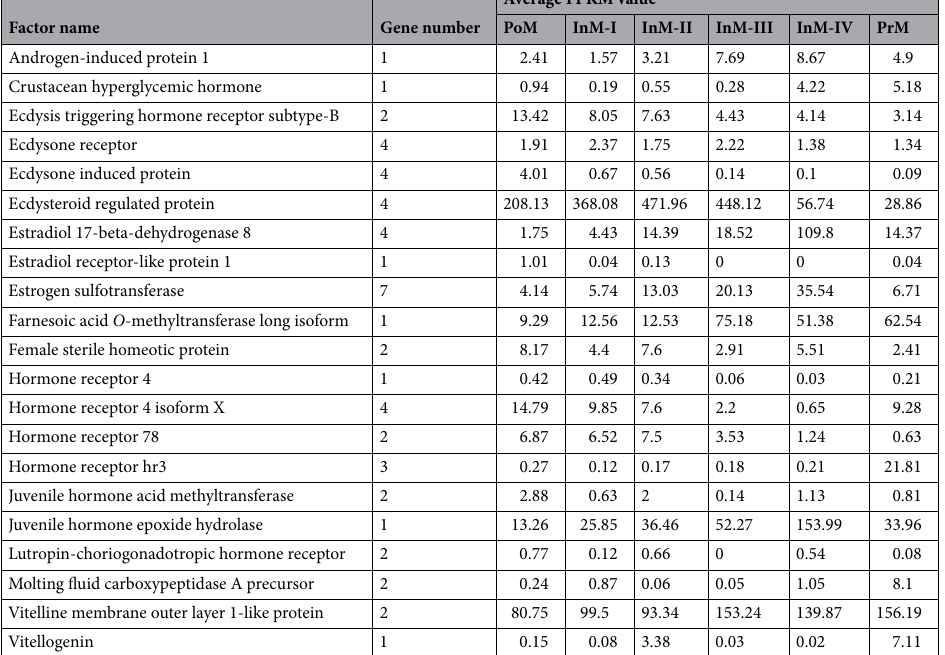
Table 2. Expression levels of molting regulation-related hormone